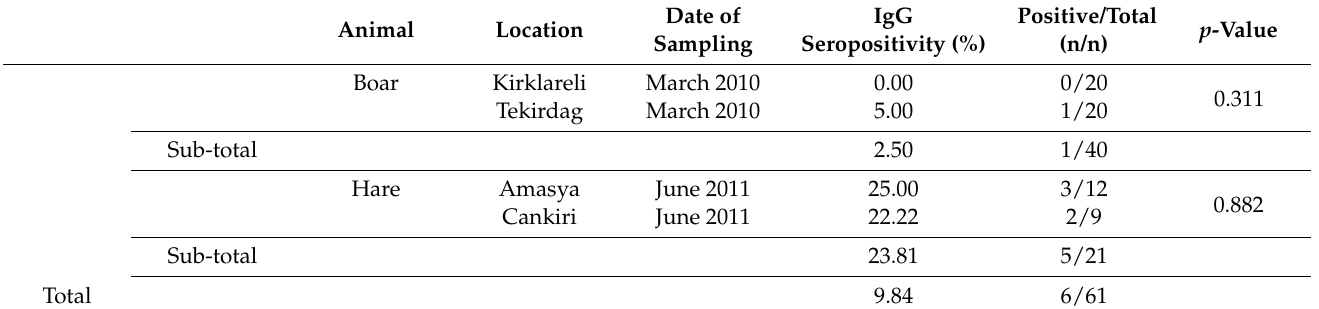
Table 2. Numbers and IgG iELISA seropositivity of CCHFV in wild animals collected from various locations of